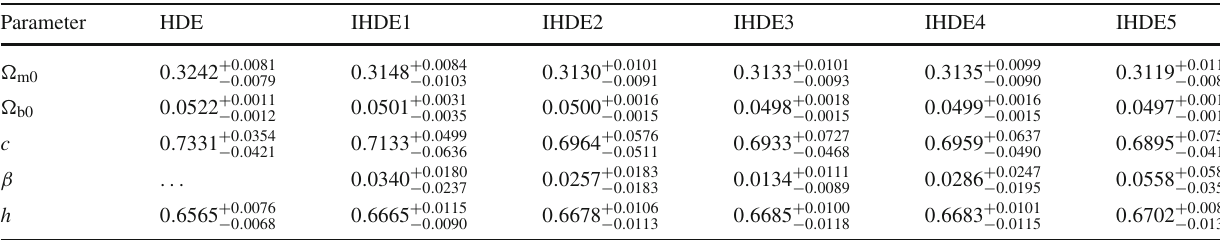
Table 2 Fitting results of the models. Best-fit values with ± 1 σ errors are presented